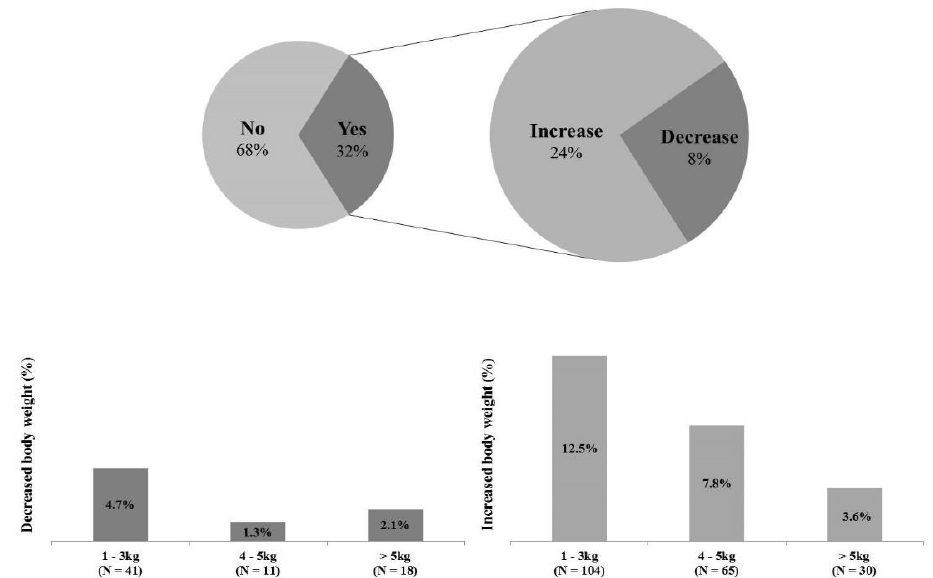
Figure 3. Changed in body weight before and during COVID-19. Among a total of 834 participants, 565 participants (68.0%) responded “maintenance” to the body weight questions, and 269 participants (32.0%) answered “changes”. Of the participants who answered ‘changes’, 199 participants (24.0%) filled in the increased weight, and 70 participants (8.0%) recorded the decreased weight.